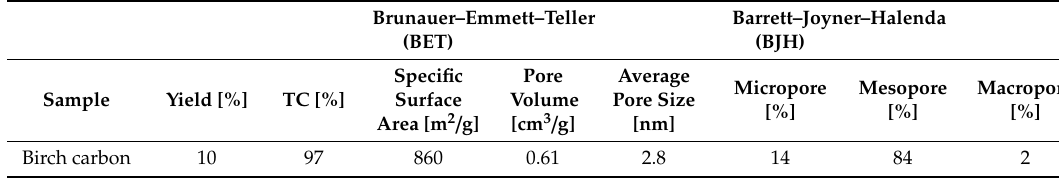
Table 1. Characterization results of produced activated carbon